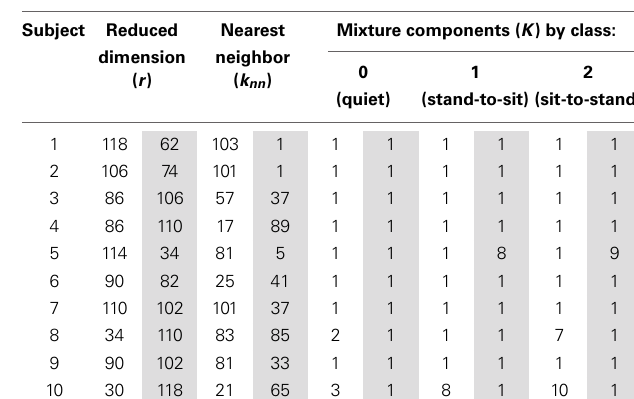
Table 1 | Optimized LFDA-GMM parameters for each subject and condition. Subject Reduced Nearest Mixture components ( K ) by class: